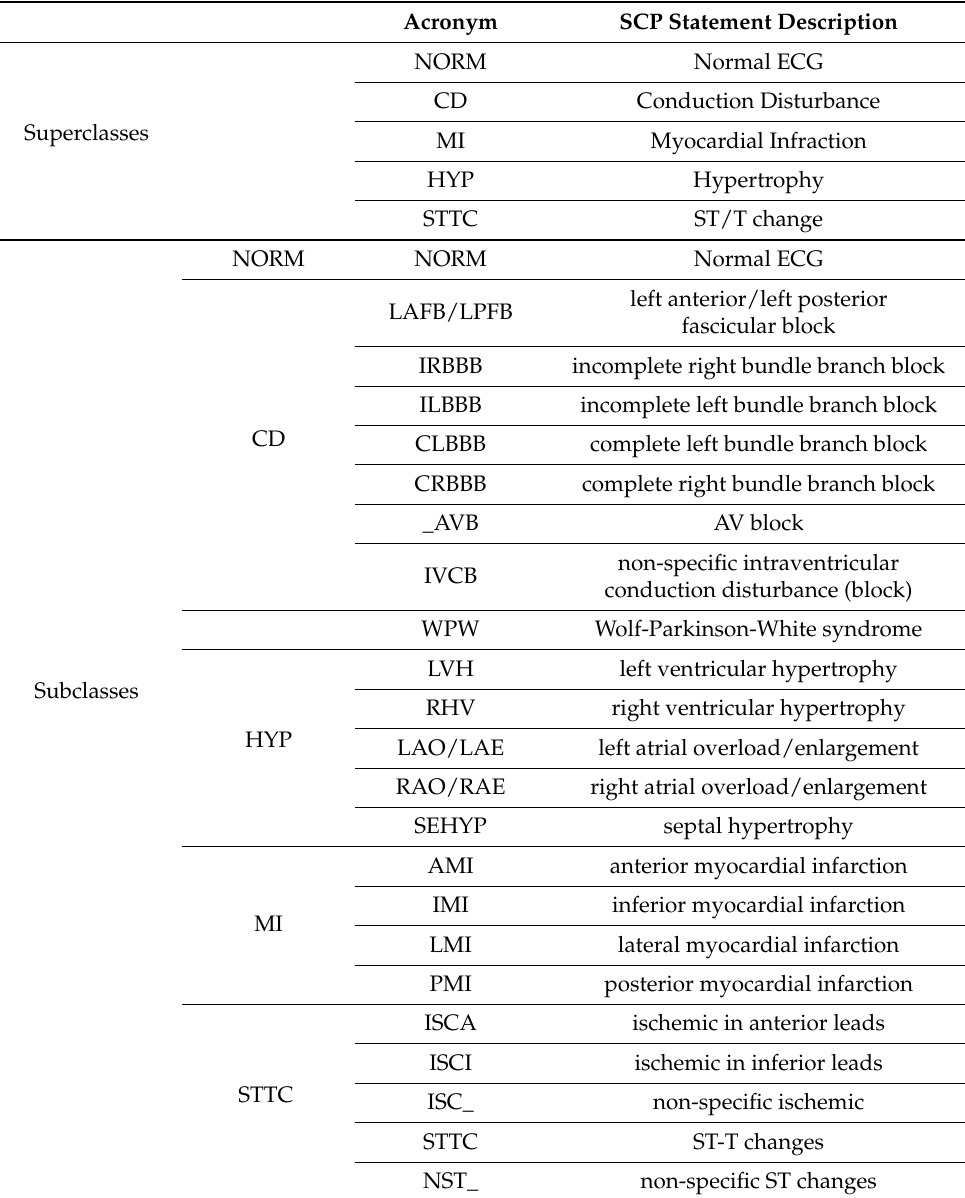
Table 1 [19]. The entire dataset was split into 60:20:20 ratio and used as training (13,101), validation (4367), and test sets (4368), respectively. Table 1. SCP-ECG acronym descriptions for super- and subclasses